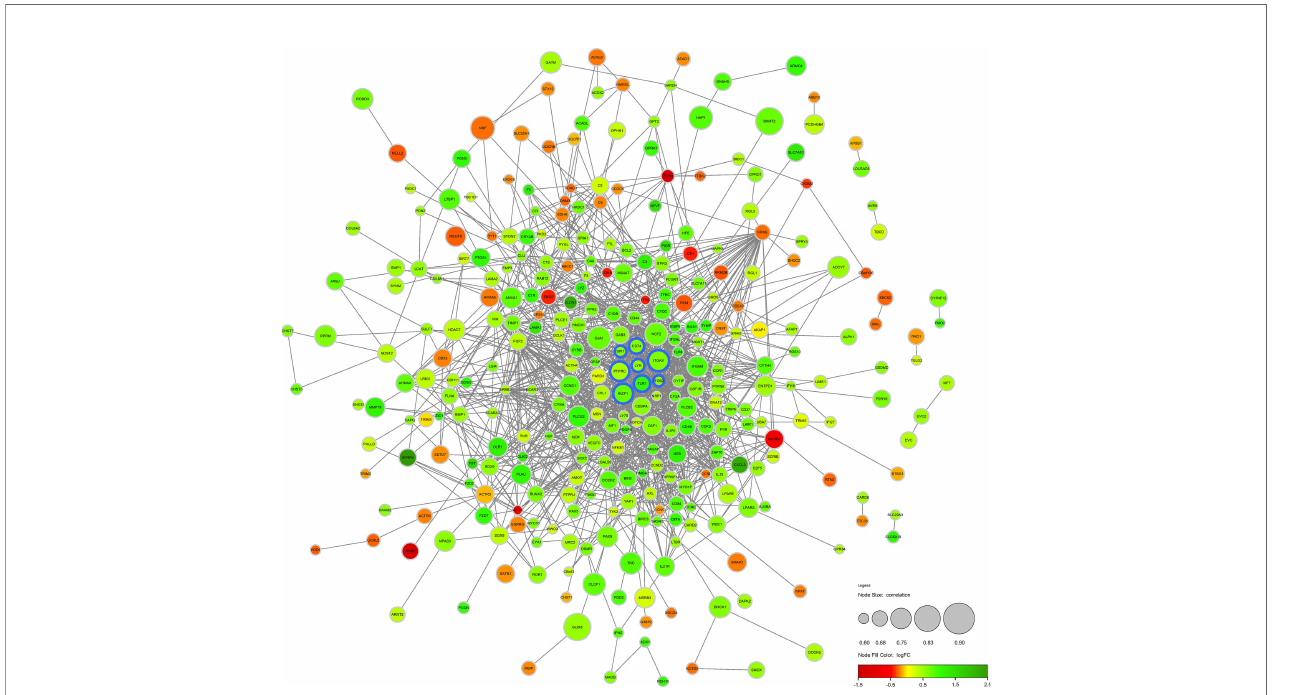
FIGURE 4 | Protein-protein interaction network of DECD8+TRGs. The circular diameter of the node represents the Pearson correlation coef fi cient between a speci fi c gene and CD8+T cell abundance. The nodes with blue outline represent Hub DECD8+TRGs, the green nodes represent positive logFC, and the red nodes represent negative logFC. FC, fold